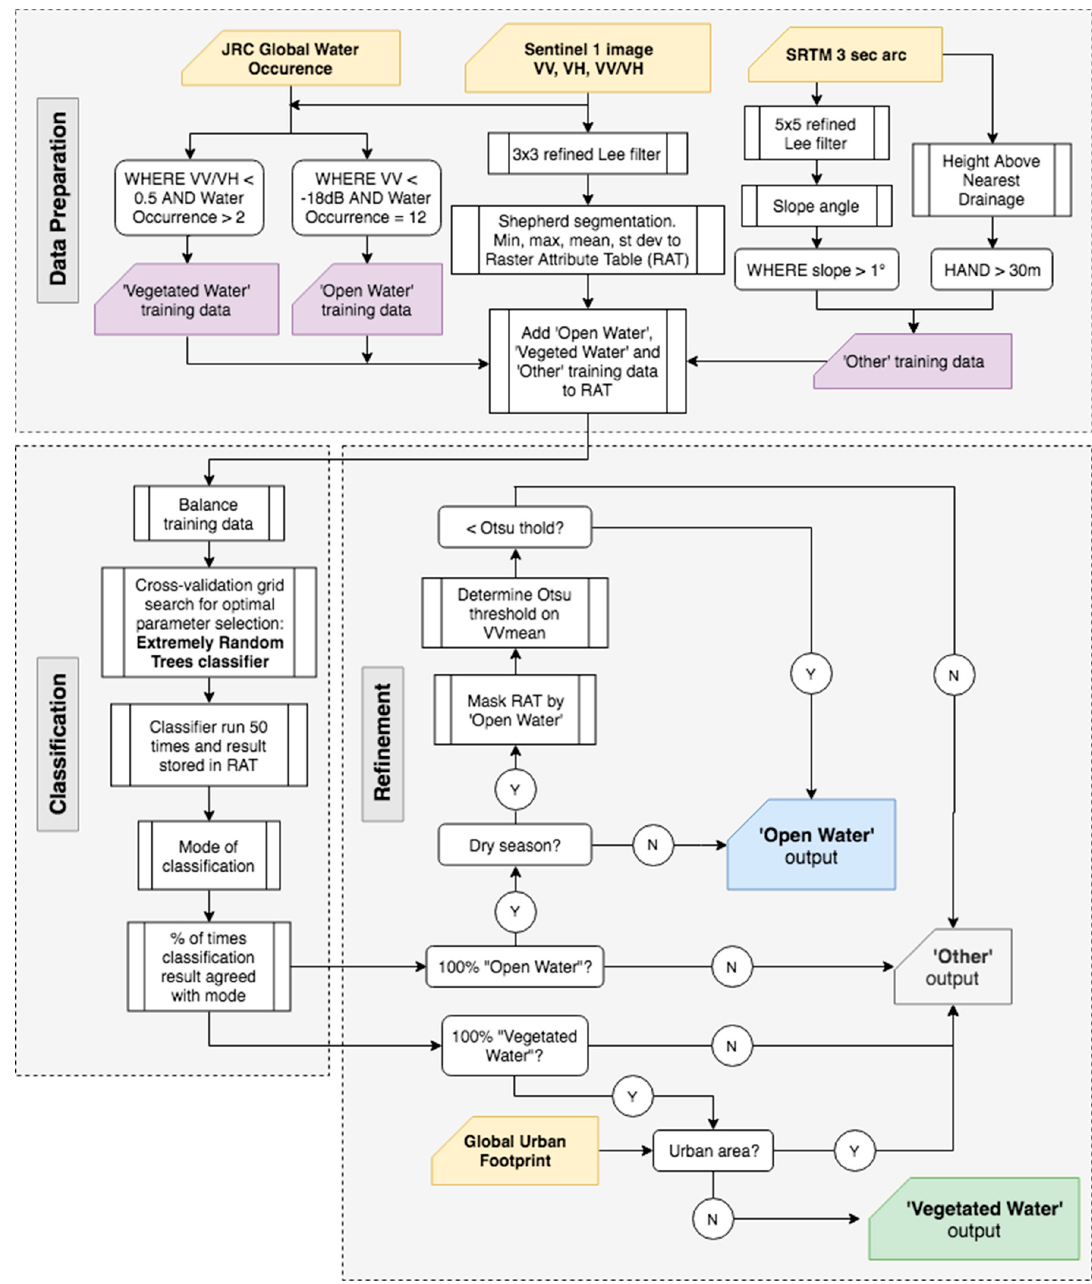
Figure 4. Flow diagram summarising the classification routine for open and surface water bodies using Sentinel 1 radar imagery.